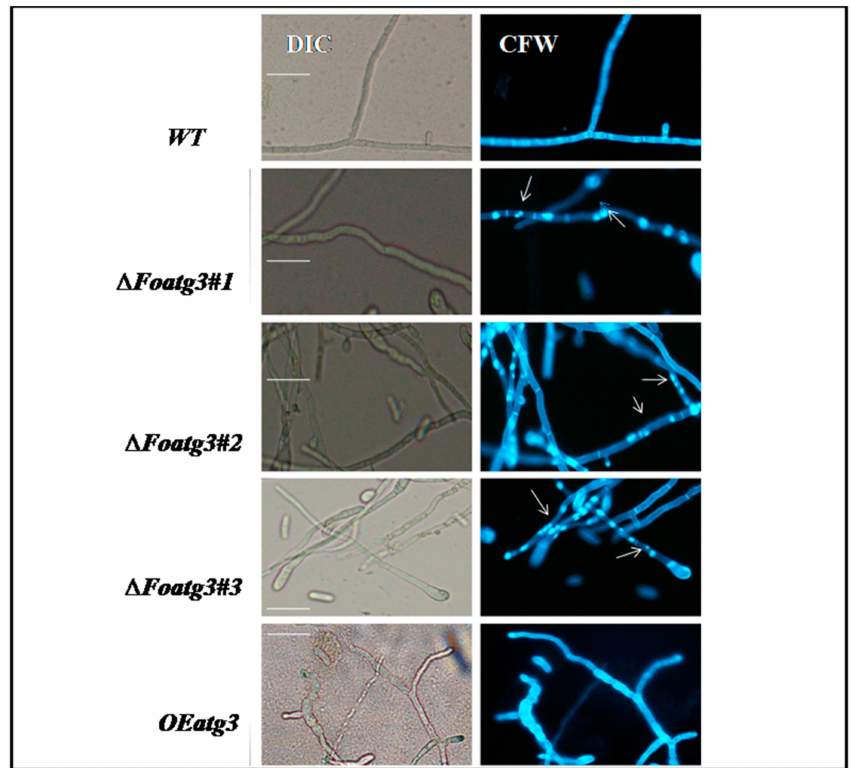
Figure 4. Hyphae from Foatg3 mutants contain multinucleated compartments. Image represents hyphae of the nitrogen starvation strains which were stained with calcofluor white (CFW). Micro arrows indicating the hyphal compartment which contains more than one nucleus. Error Bar = 10 µ